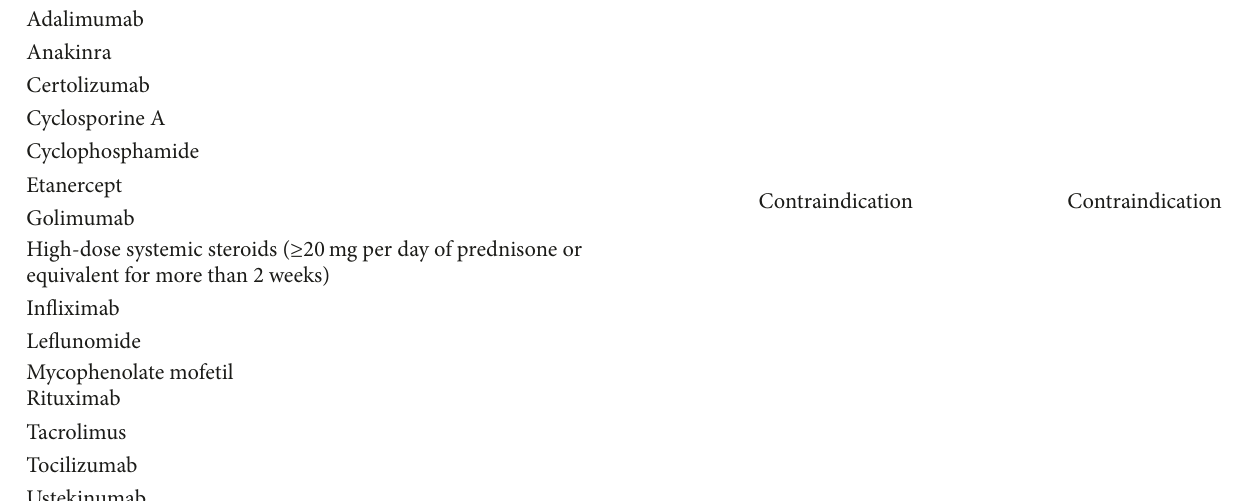
Table reproduced with permission from Swiss Medical Weekly—an open access publication of EMH published in accordance with the terms of the Creative Commons Licence Attribution-NonCommercial-NoDerivatives 4.0 International. has been documented without subsequent infection [38,